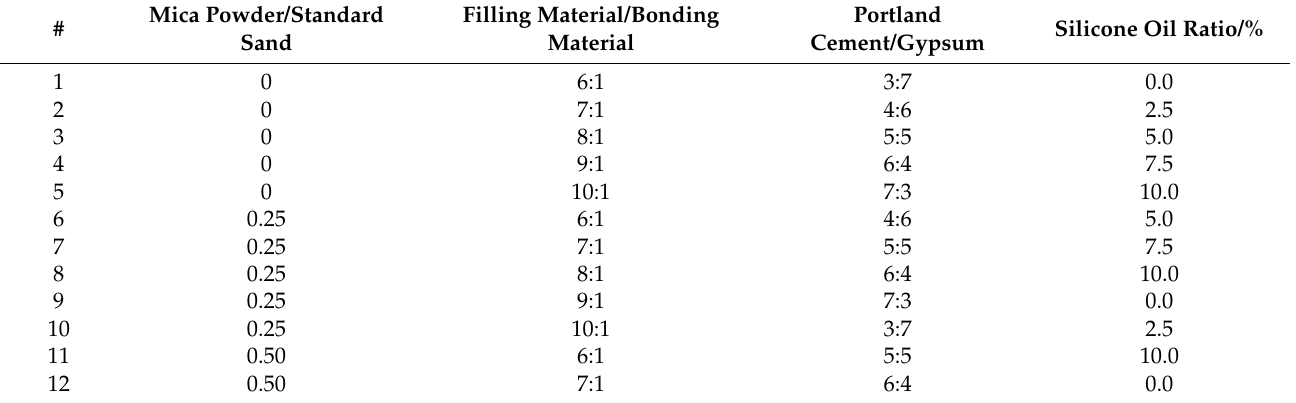
Table 2. Test schemes of material